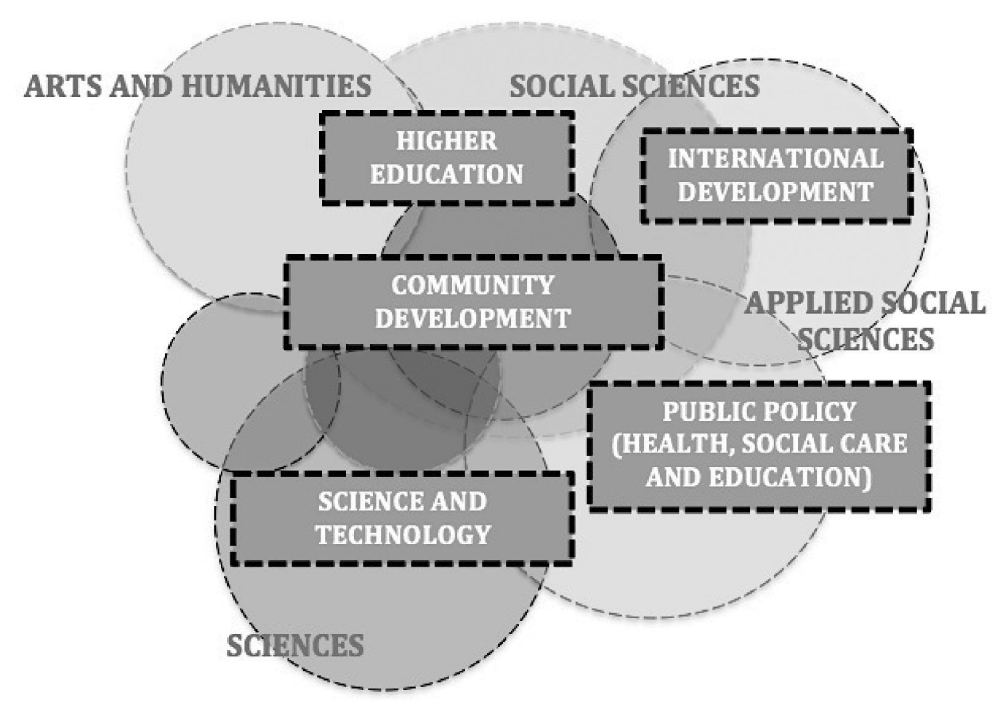
Figure 2: Final iteration of the (inter)disciplinary/(cross)sectoral research